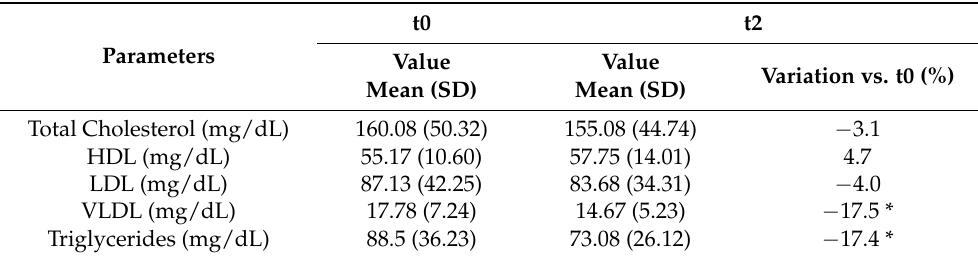
Table 2. Descriptive statistics for the lipid profiles measured at baseline (t0) and after 60 days (t2) of BBR-PP